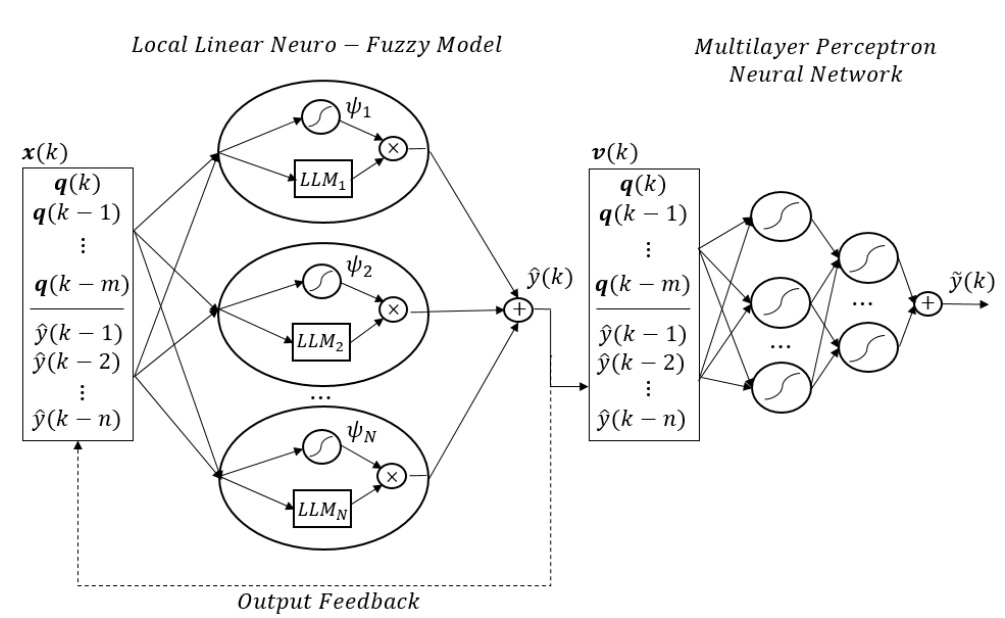
Figure 1. Illustration of the combined recurrent local linear neuro-fuzzy model and multilayer perceptron neural network